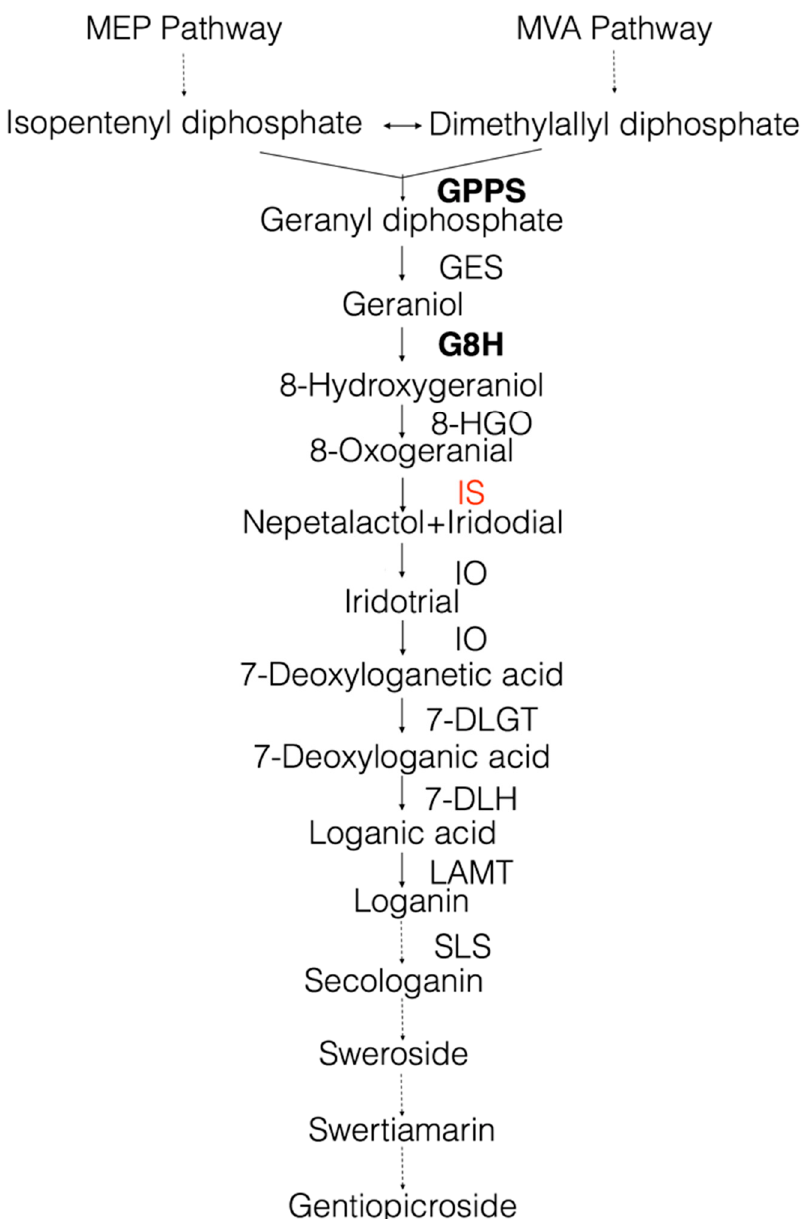
Figure 1. Schematic representation of the proposed in secoiridoid pathway. GPPS, geranyl diphosphate synthase; GES, geraniol synthase; G8H, geraniol 8-hydroxylase; 8-HGO, 8-hydroxygeraniol oxidoreductase; IS, iridoid synthase; IO, iridoid oxidase; 7-DLGT, 7-deoxyloganetic acid glucosyltransferase; 7-DLH, 7-deoxyloganic acid hydroxylase; LAMT, loganic acid O-methyltransferase; SLS, secologanin synthase. Genes in bold letters were previously cloned in S. mussotii ; the gene in red was identified in this study.